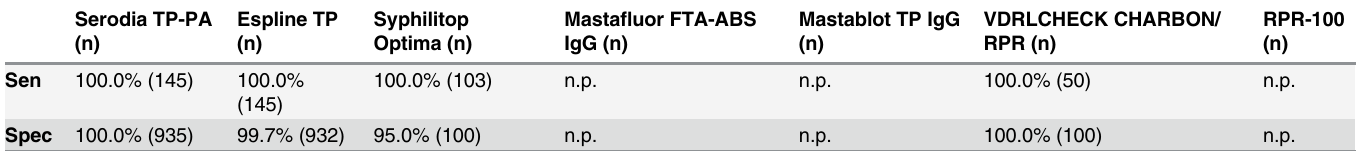
Table 1. Performance characteristics of the serological tests used in this study, as reported by the manufacturer. Sen = Sensitivity, Spec = Specificity, n.p. = not provided. Serodia TP-PA (n)